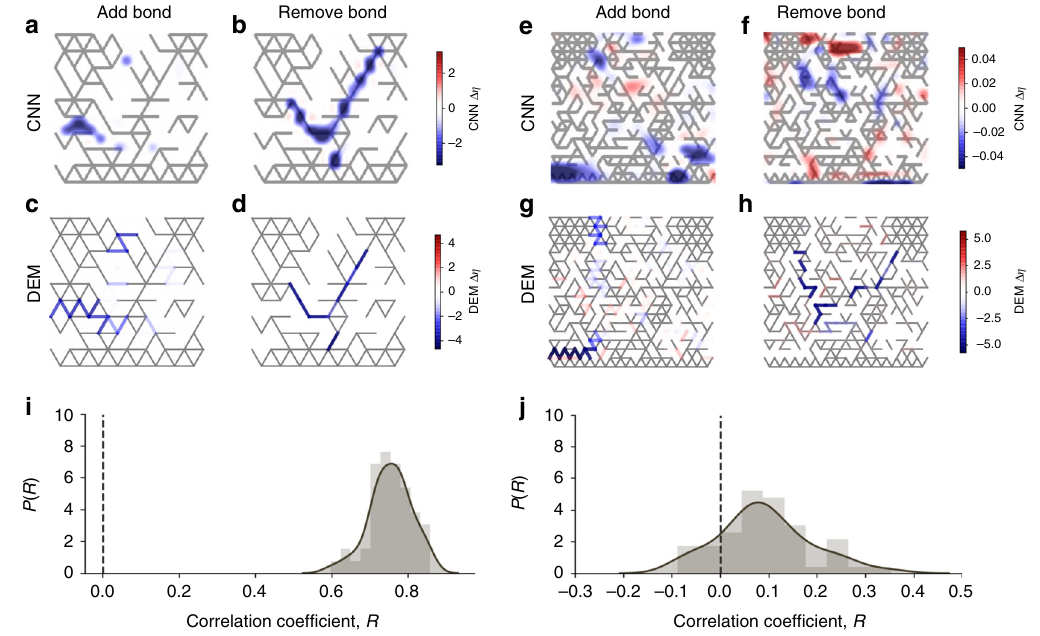
Fig. 7 Functional heatmaps identify mechanically relevant regions of structures. Heatmaps showing the spatial distribution of the changes in ef fi ciency associated with bond addition ( a , c ) or bond removal ( b , d ), as computed by the CNN model ( a , b ) or the DEM model ( c , d ), in one example structure that lays on a 172-bond lattice. Blue shades correspond to regions that lead to lowered ef fi ciency, while red regions lead to increased ef fi ciency. i Distribution of the correlation coef fi cient R between CNN and DEM values of Δη , see Methods for details e – j Same, for a structure of the 694-bond lattice, but still using the CNN model trained with 172-bond structures. The fi gure shows that information of a smaller lattice can be transferred to a larger one and still be used to identify functional regions of